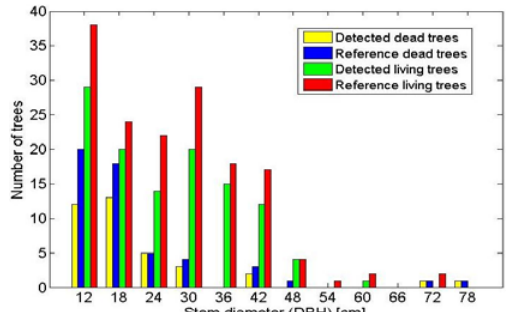
Figure 6. Distribution histogram of detected and reference trees according to the DBH – leaf-off dataset